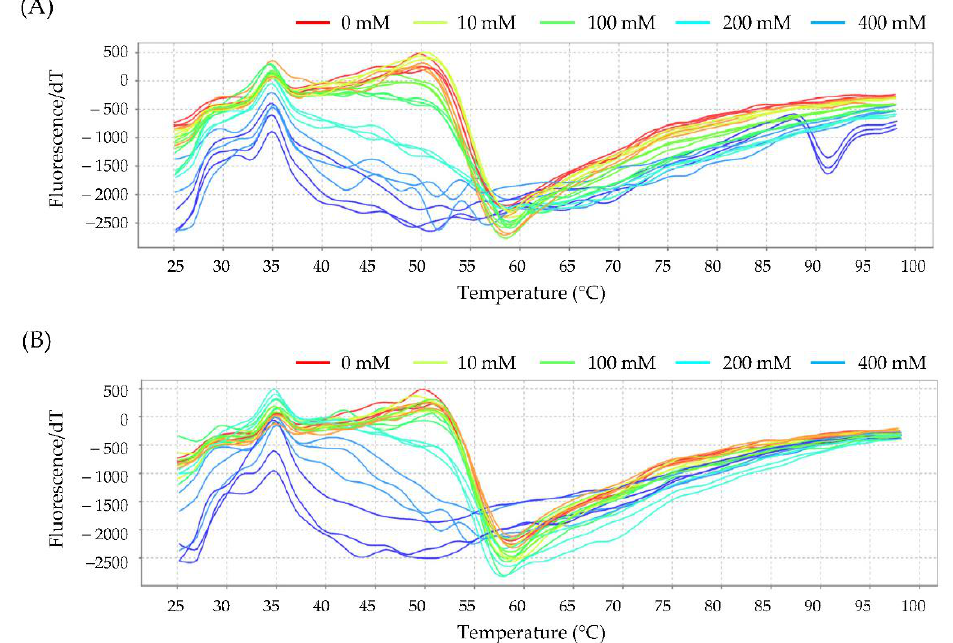
Figure 7. Melting profile of hemoglobin (Hb) with ( A ) glycidol or ( B ) acrylamide. The figures show the profile of the derivative of fluorescence emission as a function of temperature (dF/dT). Human Hb (0.125 mg/mL) and the ligand (0, 10, 100, 200, and 400 mM each for glycidol or acrylamide) were reacted at 37 °C for 3 h before analysis using the thermal shift assay. Table 3. Melting temperature of hemoglobin in the presence of glucose and glycidol or